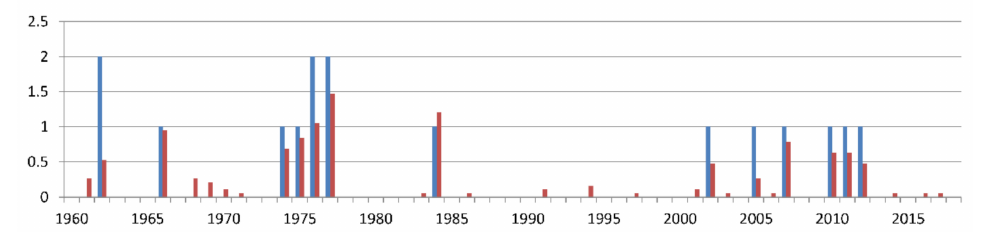
Figure 2. Inter-annual variation of WPECEs in the key area (red solid bars) and the key station (blue solid bars) in Xinjiang, China during 1961 to 2018 (units: